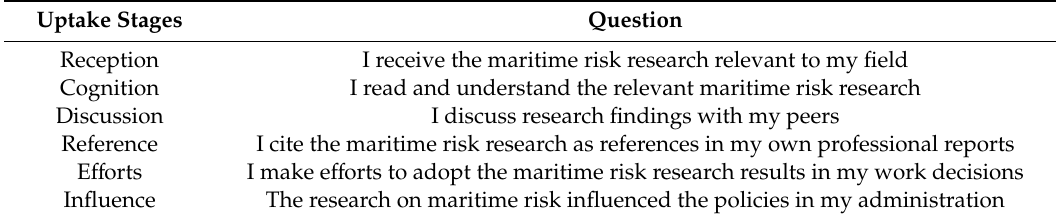
Table 4. Research uptake assessment stages and questions.